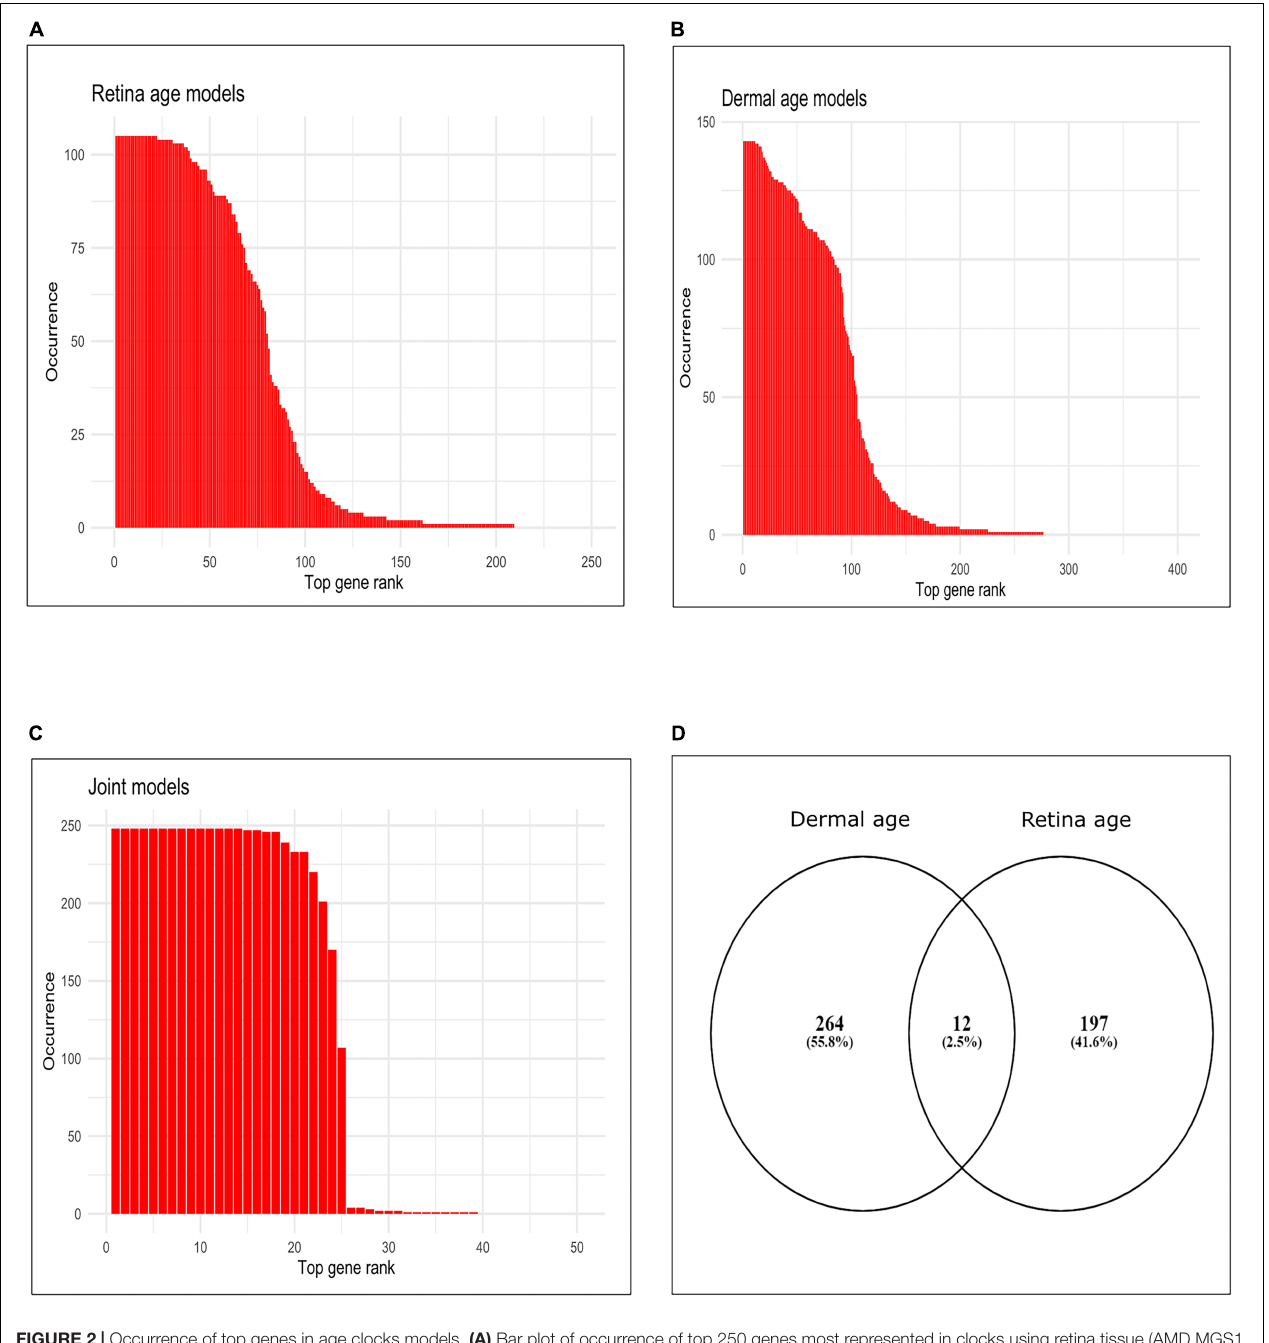
FIGURE 2 | Occurrence of top genes in age clocks models. (A) Bar plot of occurrence of top 250 genes most represented in clocks using retina tissue (AMD MGS1, conserved feature set), (B) bar plot of occurrence of top 400 genes most represented in clocks using dermal fibroblast samples, (C) bar plot of occurrence of top 50 genes most represented in clocks developed using combined retina-dermal datasets, (D) Venn diagram of genes represented in retina and dermal fibroblast